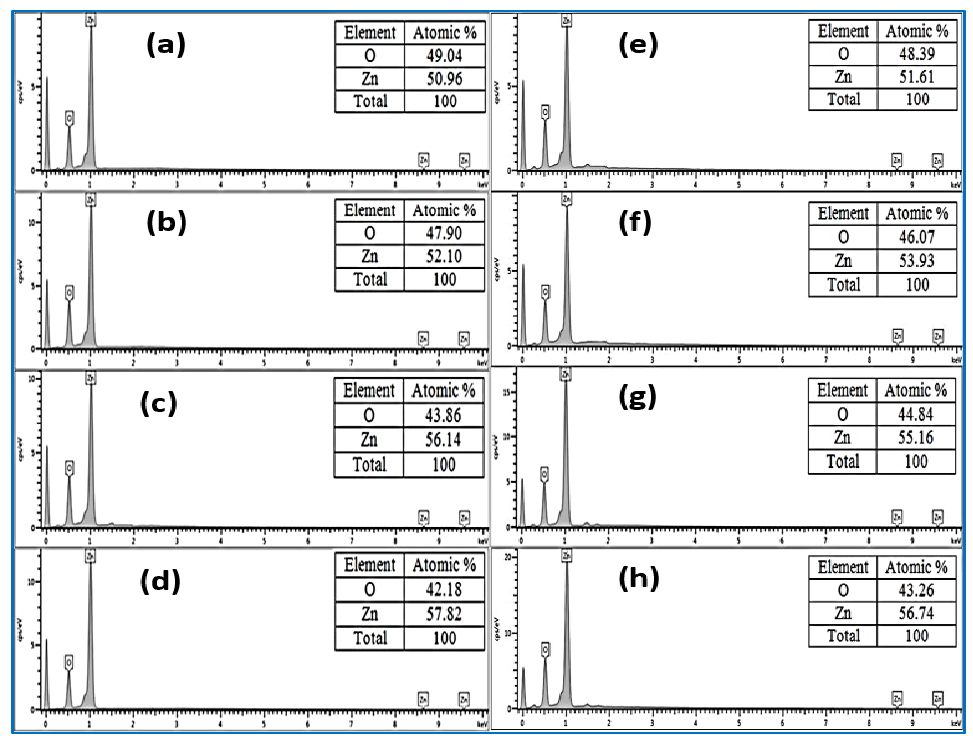
Figure 5. Typical EDX analysis of ZnO nanorods for di ff erent precursor concentrations in the absence of air bubbles: ( a ) 0.01 M, ( b ) 0.025 M, (c) 0.05 M and ( d ) 0.075 M and the presence of air bubbles: ( e ) 0.01 M, ( f ) 0.025 M, ( g ) 0.05 M and ( h ) 0.075